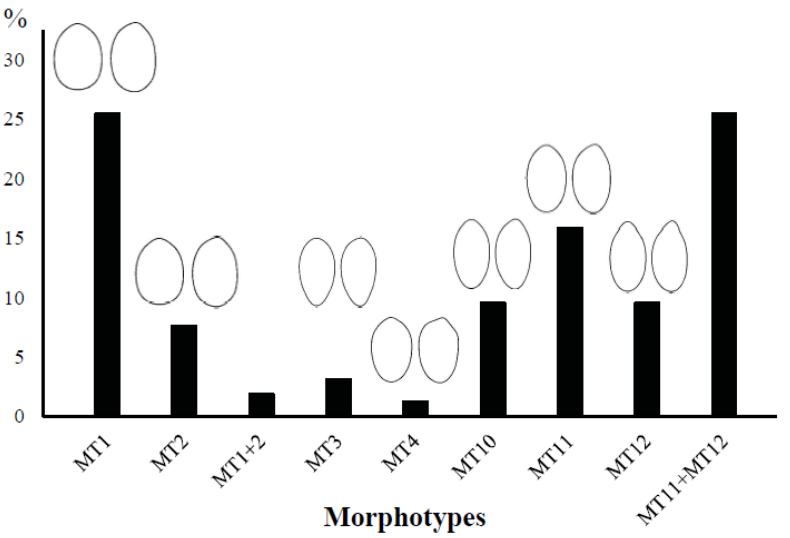
Figure 6. Percentage of archaeological stones affiliated with LDA-defined morphotypes.